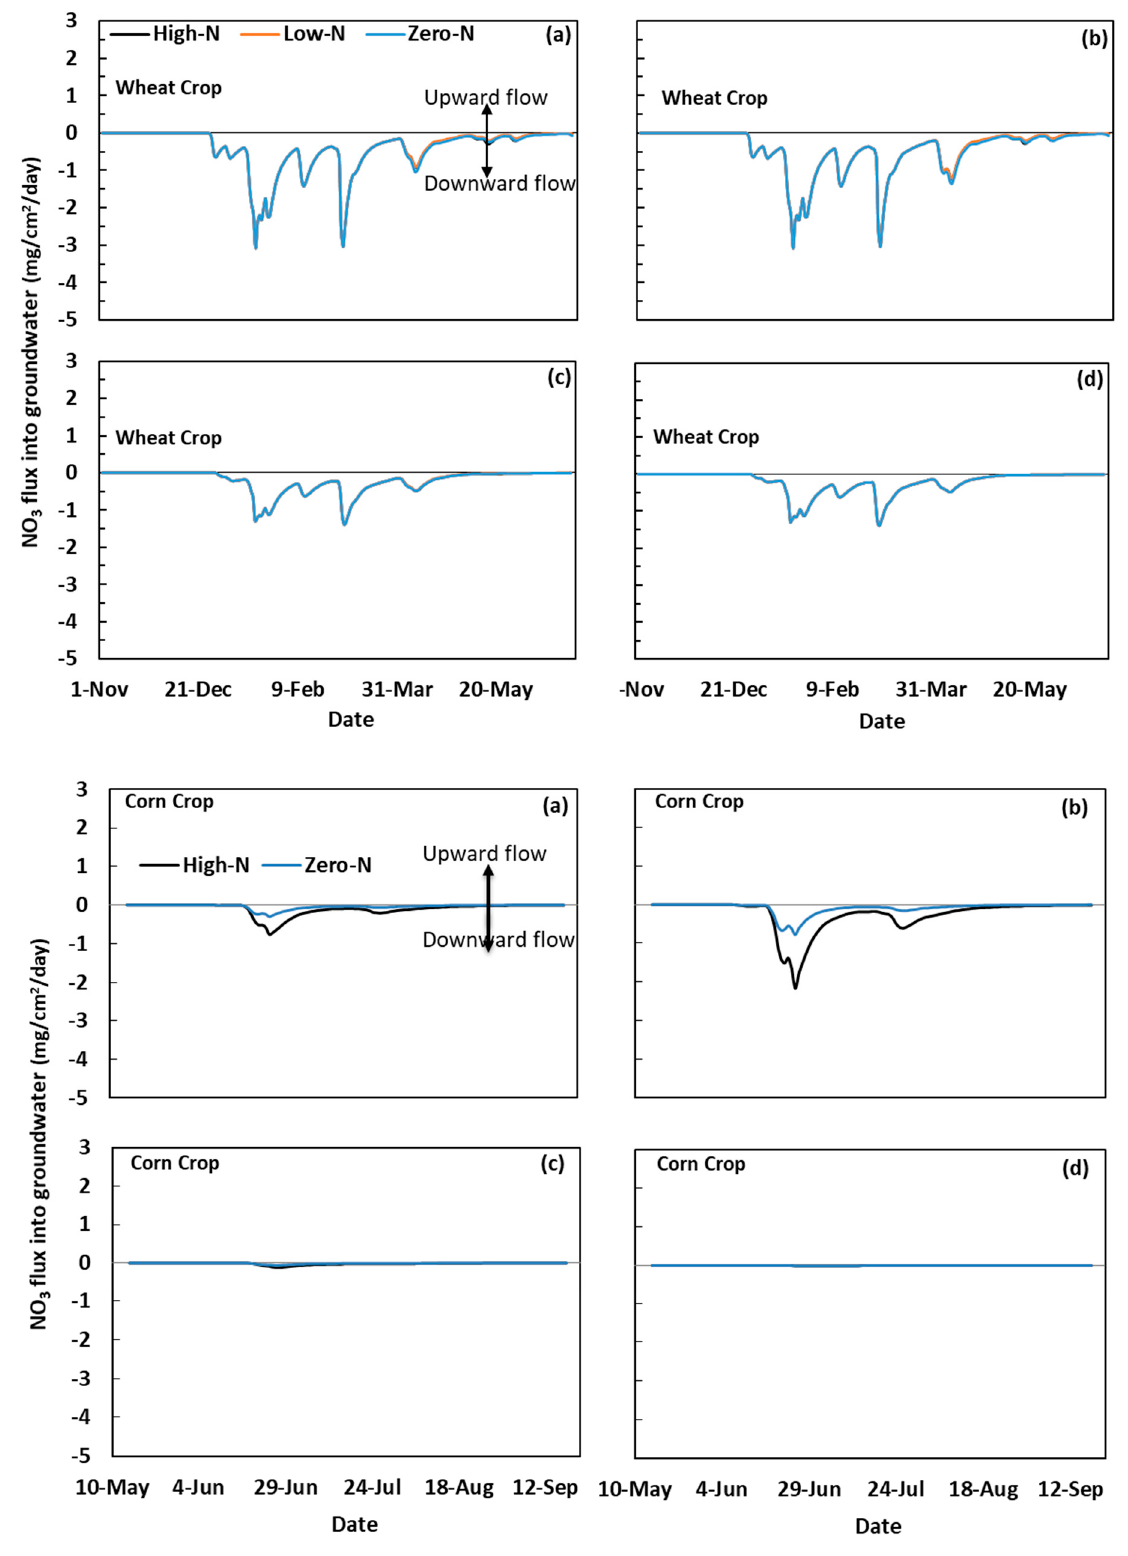
Figure 8. Simulated NO 3 flux into groundwater for the wheat and corn growing seasons under the: ( a ) 100%, ( b ) 125%, ( c ) 75%, and ( d ) 50% rainfall scenarios.